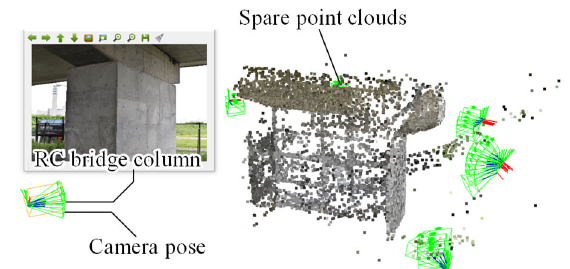
Figure 5. Sparse point clouds and camera poses of the RC bridge